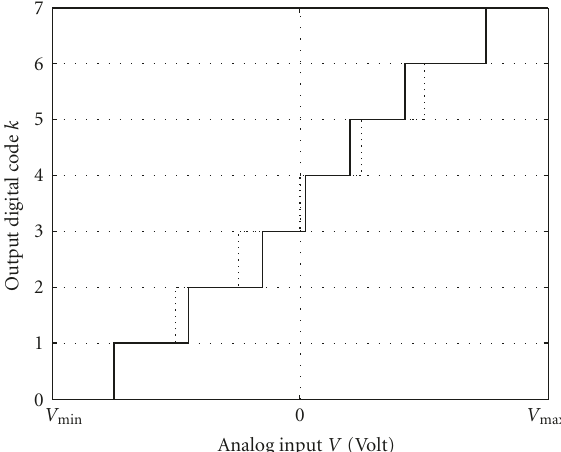
Figure 3: The relationship between the analog input signal v and the digital output code k from an ideal n = 3bits ADC (dashed line) and a practical one (solid